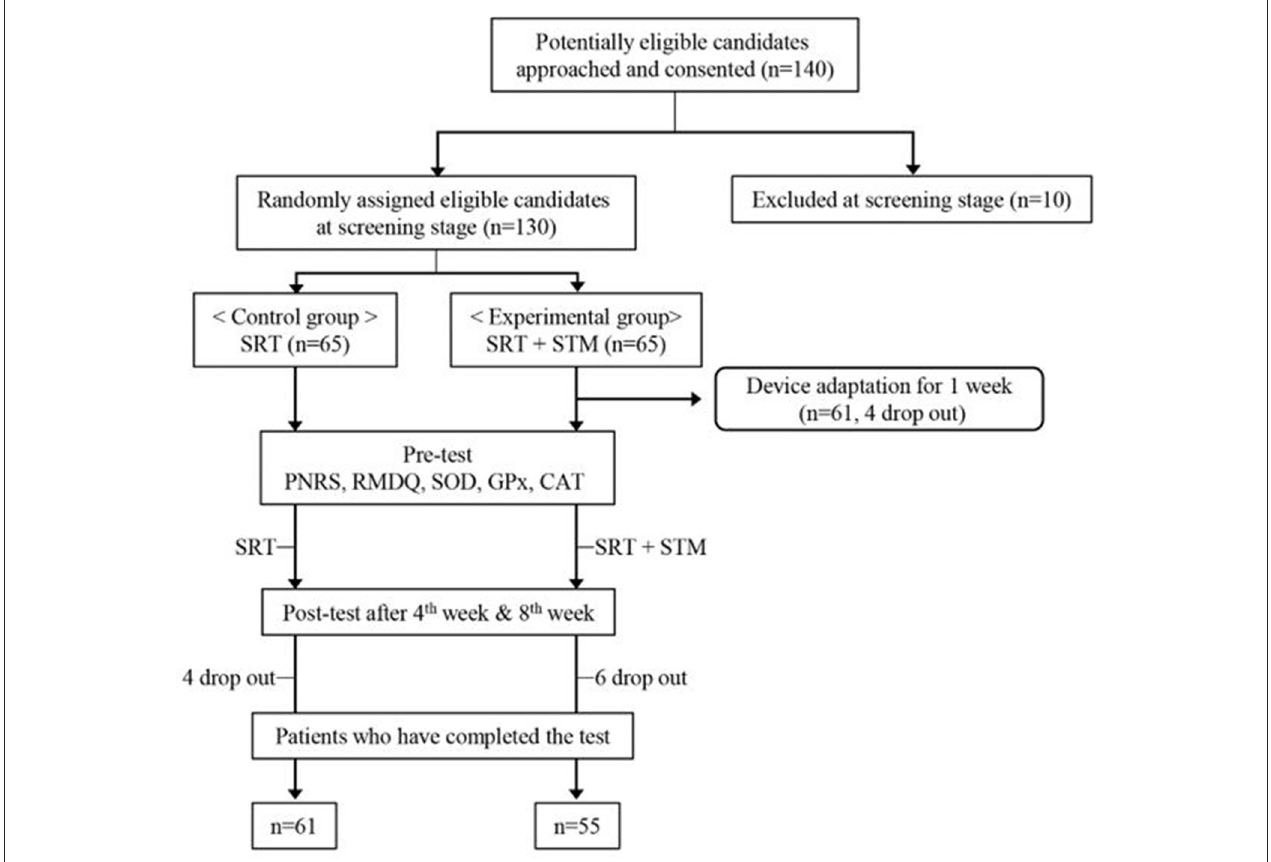
FIGURE 1 | Study procedures.